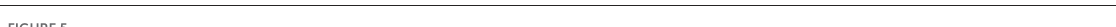
FIGURE5 layers III and V with predominantly medium-sized pyramidal cells. Layer V was not subdividable into Va and Vb compared to adjacent area BA9 (A–C) . Area SFS2 mainly differed from SFS1 by a low cell density in upper layer IIIa and higher cell density in deeper layer IIIc with larger pyramidal cells in IIIc. Layer IV was poorly developed, and layer VI was prominent with a high cell density (D–F) . Area MFG1 was characterized by large pyramidal cells in deeper layer III and upper layer V, and layer IV was visible. There was no distinct border to the white matter (G–I) . In contrast, the cells in layers III and VI of area MFG2 were mostly equal in cell size and did not contain large pyramidal cells, resulting in a more homogeneous appearance than in other identified areas (J–L) . Scale bar of 500 µ m in (C) refers to all (A–L) .